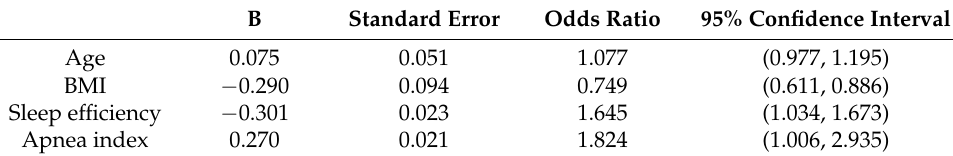
Table 4. Determinants of cognitive impairment on binary logistic regression analysis results.